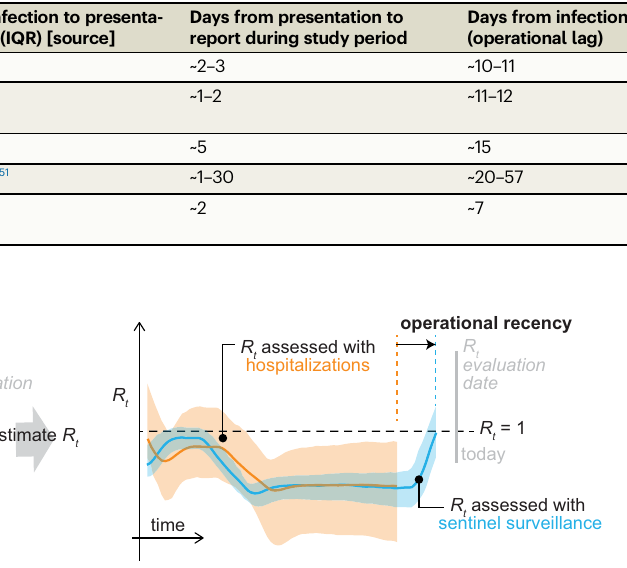
Fig. 1 | Theoretical diagram of the instantaneous effective reproductive number R ( t ) derived from hospitalizations (orange) and sentinel surveillance (blue). Because symptom onset typically occurs sooner in the course of disease than a visit to the emergency department or hospitalization, sentinel cases can